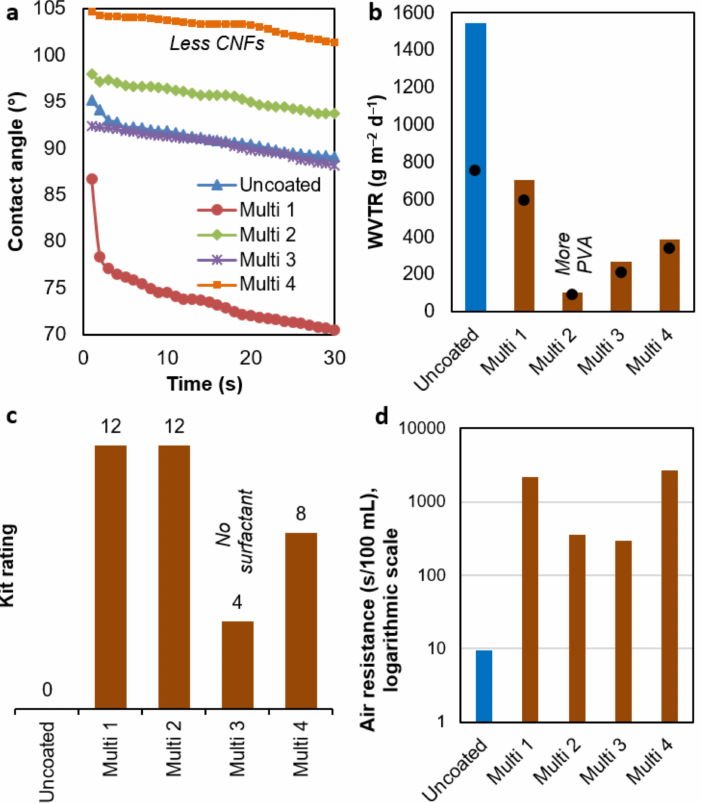
Figure 6. Key barrier properties of sheets coated with multi-purpose suspensions: ( a ) dynamic contact angle; ( b ) maximum WVTR (columns), 24 h average WVTR (dots); ( c ) results of greaseproof tests, and ( d ) air resistance (Gurley method). The engraved roll was used in all